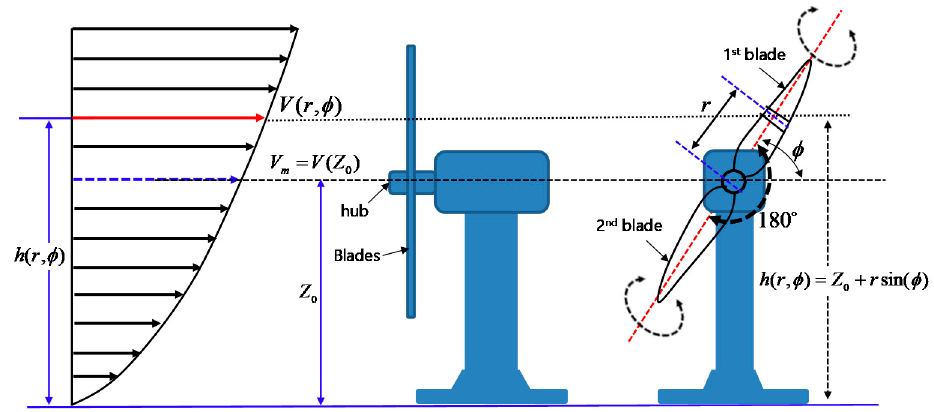
Figure 1. Individual pitch control (IPC)-based two-blade wind turbine system under the wind shear effect.